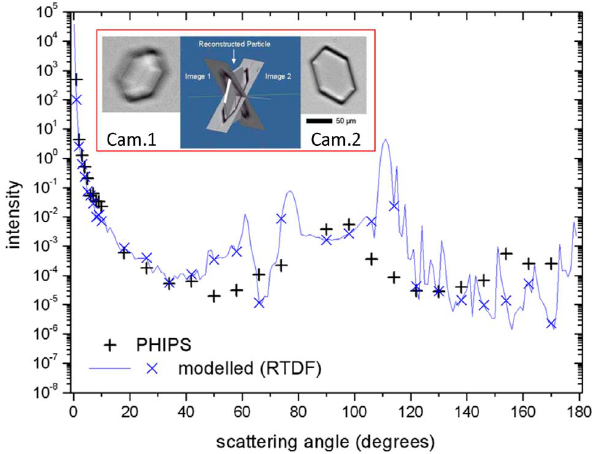
Figure 13. Comparison between the experimentally obtained polar scattered signal and the one modeled using RTDF for a hexagonal ice crystal observed during the HALO02 campaign. The inset shows the two images collected for the crystal and the reconstructed 3D model.